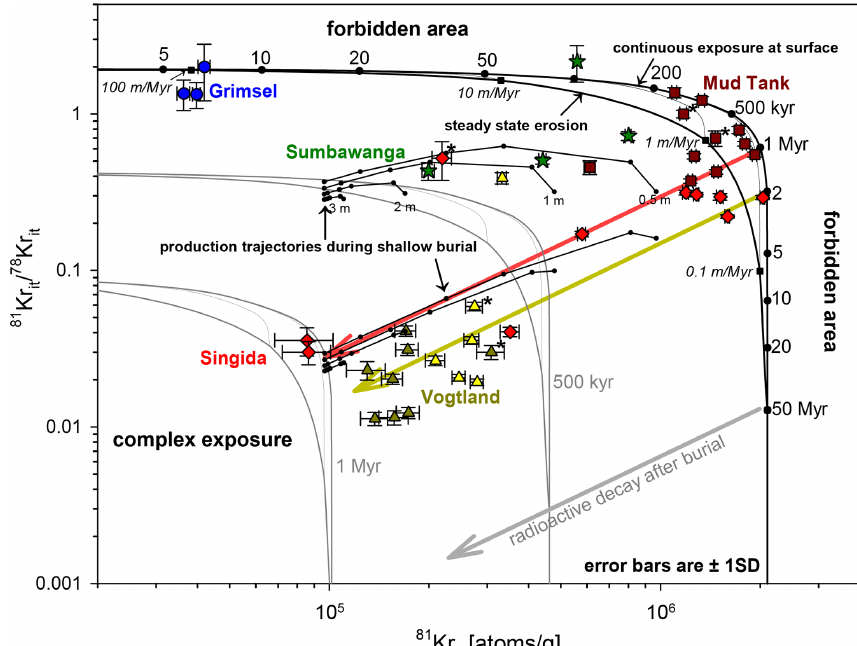
Figure 8. Unravelling histories of exposure and burial. In a 81 Kr / 78 Kr it vs. 81 Kr two-isotope plot, analogous to similar diagrams used for 26 Al and 10 Be (Dunai, 2010; Lal, 1991) or 21 Ne and 10 Be (Kober et al., 2009), histories of exposure and burial can be deciphered. The spallogenic 81 Kr / 78 Kr it production ratio (1.94 ± 0.09; 1SE calculated from samples MUD-1 and MUD-11; see main text), the 81 Kr it production rate (6.33 ± 0.32atomsg − 1 yr − 1 ; this study) and the 81 Kr half-life (229 ± 11kyr, Baglin, 2008) are used to define the boundaries between areas that are forbidden (no physically plausible explanation), areas that denote simple continuous exposure or steady state erosion or complex histories that include intermittent burial. Samples that are continuously exposed at the surface may be used to test the consistency of the 81 Kr / 78 Kr it production ratio and/or 81 Kr it production rate applied. Due do the decay of 81 Kr, the 81 Kr / 78 Kr it ratio of exposed samples decreases with increasing exposure age until the 81 Kr concentration eventually saturates (production rate = decay rate) after about 8–9 half-lives (this limit is dependent on the analytical uncertainties achieved). For exposures > 1Myr, the 81 Kr it / 78 Kr it ratio is a direct proxy for the exposure age (Marti, 1967), independent of scaling factors or shielding as long as the latter is constant through time (Marti, 1967). Upon burial the previously acquired 81 Kr it inventory decays over time, allowing, in the case of a single period of deep burial, its duration to be determined. All samples are consistent with either continuous exposure at the Earth’s surface, exhumation at a steady rate, or with histories that include burial after exposure (“complex exposure”). Samples marked with an asterisk ( ∗ ) are those that were identified to contain fractionated and/or nucleogenic Kr (Fig. 7); results of these samples are excluded from further evaluation. The two colours used for the samples from Vogtland denote the distance they were collected downstream of their source (yellow ∼ 5km; dark yellow ∼ 15km). Symbols and colours for samples are the same as in Fig. 6. For two samples from Grimsel (GRIM-19-1 and 2) the error weighted means (1SE) of duplicate and triplicate measurements are plotted. The 81 Kr it concentrations are normalized to sea level and high latitude using LSD scaling (Lifton et al., 2014), and the standard atmosphere model to convert altitude into atmospheric pressure (Balco et al., 2008). The evolution trajectories shown are calculated using a 81 Kr it / 78 Kr it production ratio of 1.94 (this study), a sea-level high-latitude 81 Kr it production rate of 6.33 (this study), the 81 Kr it half-life of 229kyr (Baglin, 2008), and a density of 2.7gcm − 3 for source rocks and/or overburden. Format of diagram after Lal (1991). The two, subordinate, steady-state erosion islands bound by the grey lines give hypothetical examples of where samples would plot had they been originally exposed at the surface and then buried at a significant depth for 500kyr, or for 1Myr. The two sets of example production trajectories illustrate regrowth at shallower depths (i.e. 3, 2, 1 and 0.5m; during 500 and 1000kyr of burial, respectively). Trajectories are vertically offset within each set for better visibility (i.e. the trajectories for the different burial depths actually originate from one point). Dots on the regrowth trajectories are for 0 years, 10, 50, 100, 500kyr and 1Myr production,